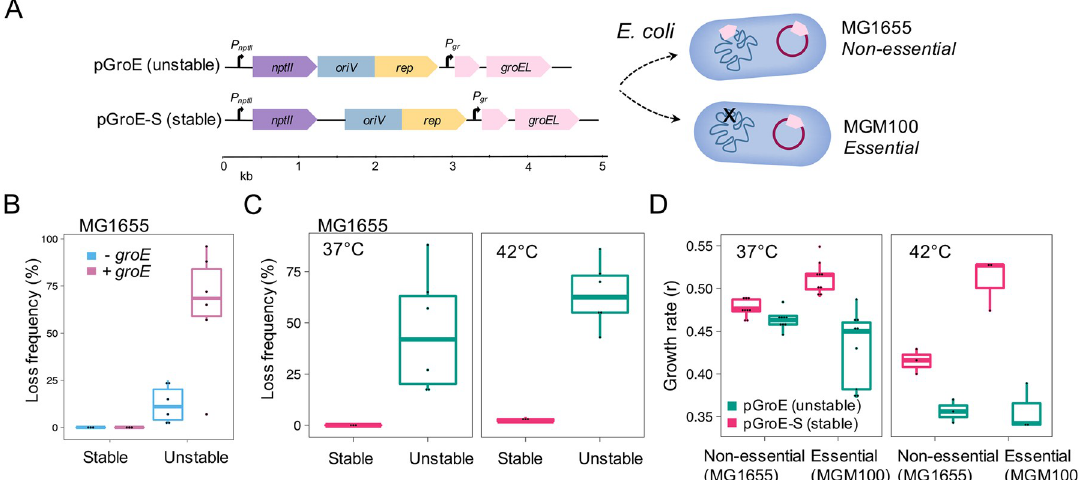
Fig 3. Characterization of plasmids encoding an essential gene. A , Genomic map of unstable pGroE and stable pGroE-S plasmids that were introduced into E . coli MG1655 (plasmid is non-essential) and E . coli MGM100 (plasmid is essential) hosts. B , Plasmid loss frequency of plasmids lacking (-) groE or encoding (+) groE in their genome in the host E . coli MG1655 (H 0 : L Wilcoxon test n = 6) C , Plasmid loss frequency of pGroE-S (stable) and pGroE (unstable) after incubation at 37˚C or at 42˚C (H 0 : L 42 > L 37 , P = 0.0091 using Wilcoxon test, n = 6). D , Growth rates of host strains E . coli MG1655 and E . coli MGM100 carrying pGroE (unstable) or pGroE-S (stable) after growth at 37˚C and 42˚C (H 0 : Gr 42 > Gr 37 , P = 0.051 using Wilcoxon test, n =